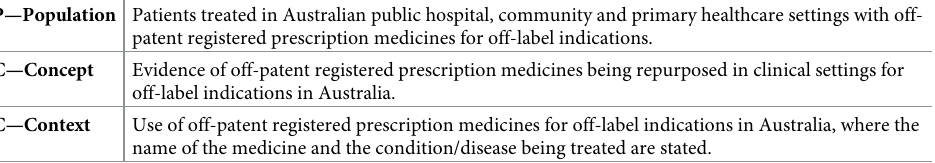
Table 1. Key inclusion